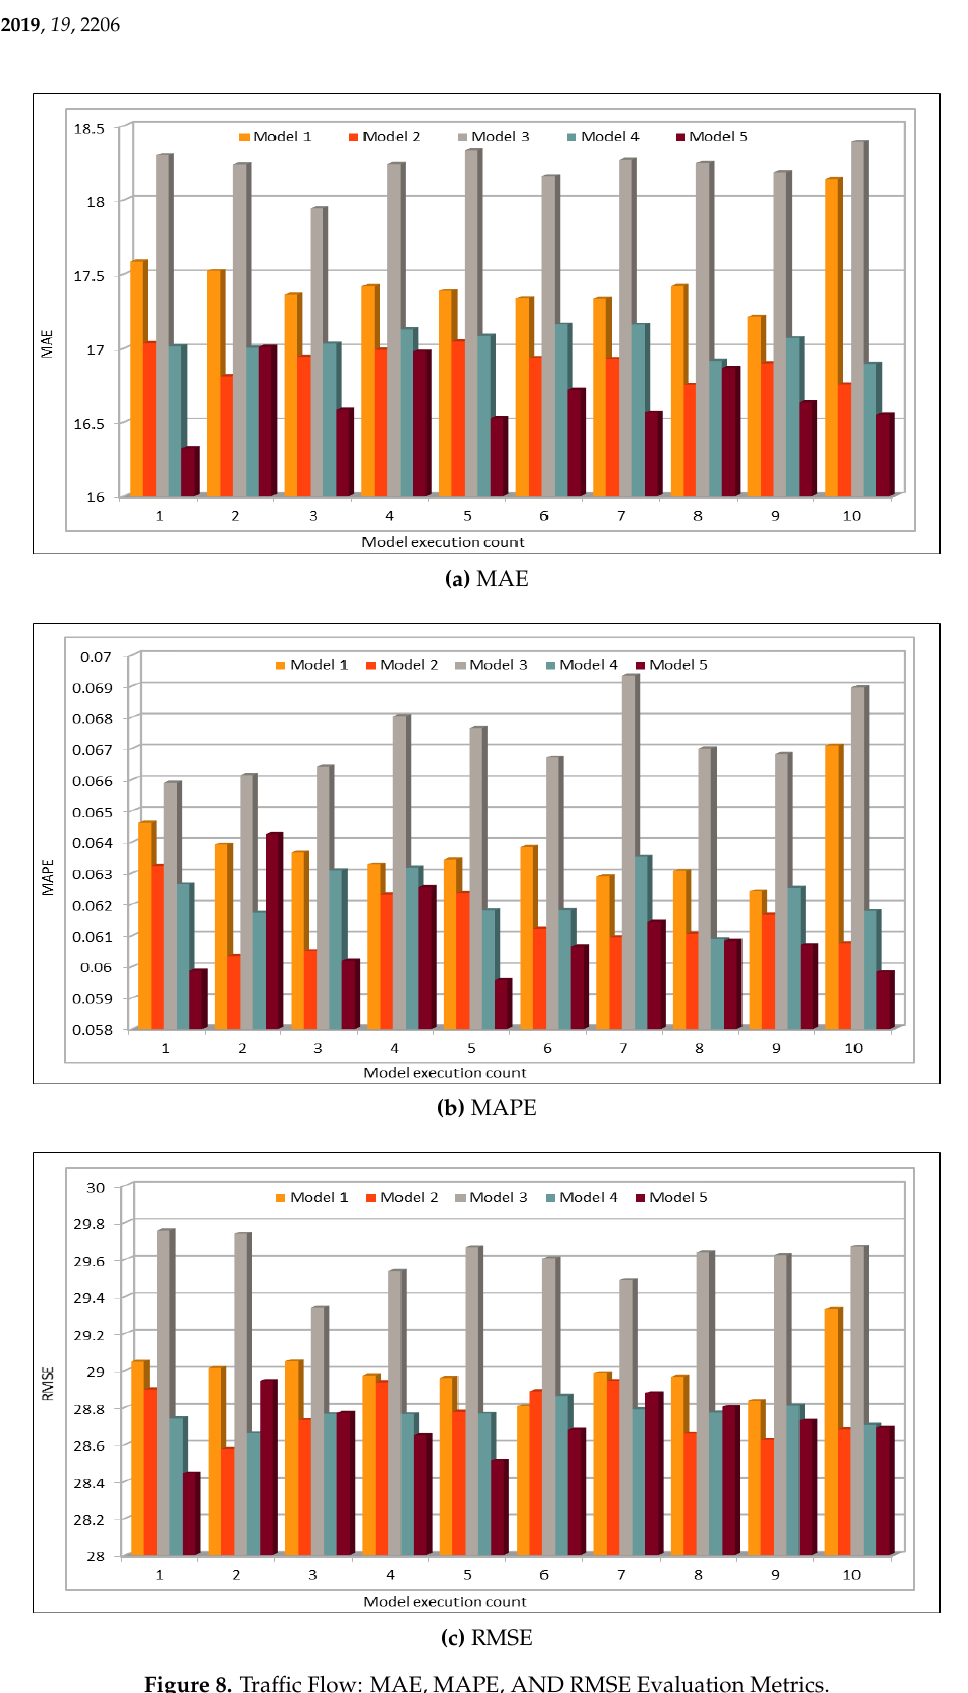
Figure 8. Traffic Flow: MAE, MAPE, AND RMSE Evaluation